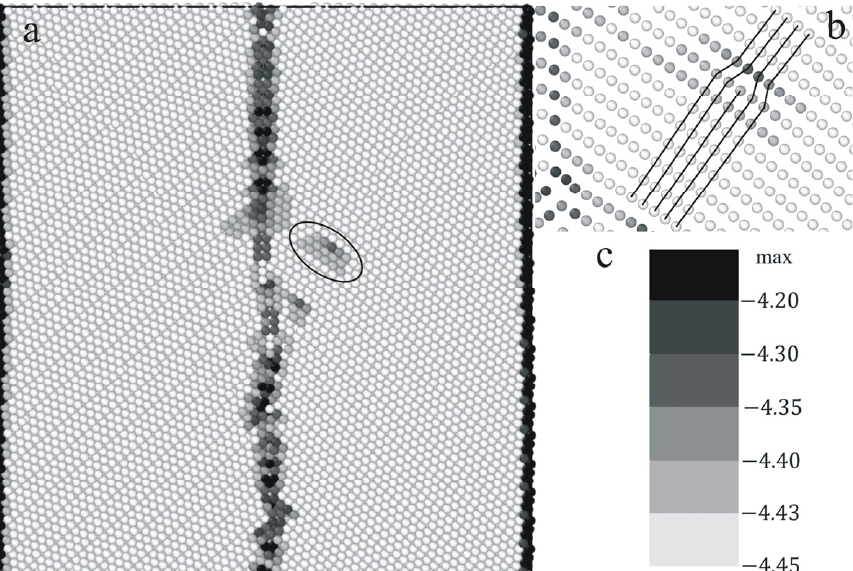
Figure 23. Atomic energy map of nonequilibrium Σ = 15 GB with a disclination dipole after relaxation at 300 K ( a ), a magnified image of lattice dislocation located near the GB in the region indicated by an ellipse ( b ) and energy levels ( c ) [119].